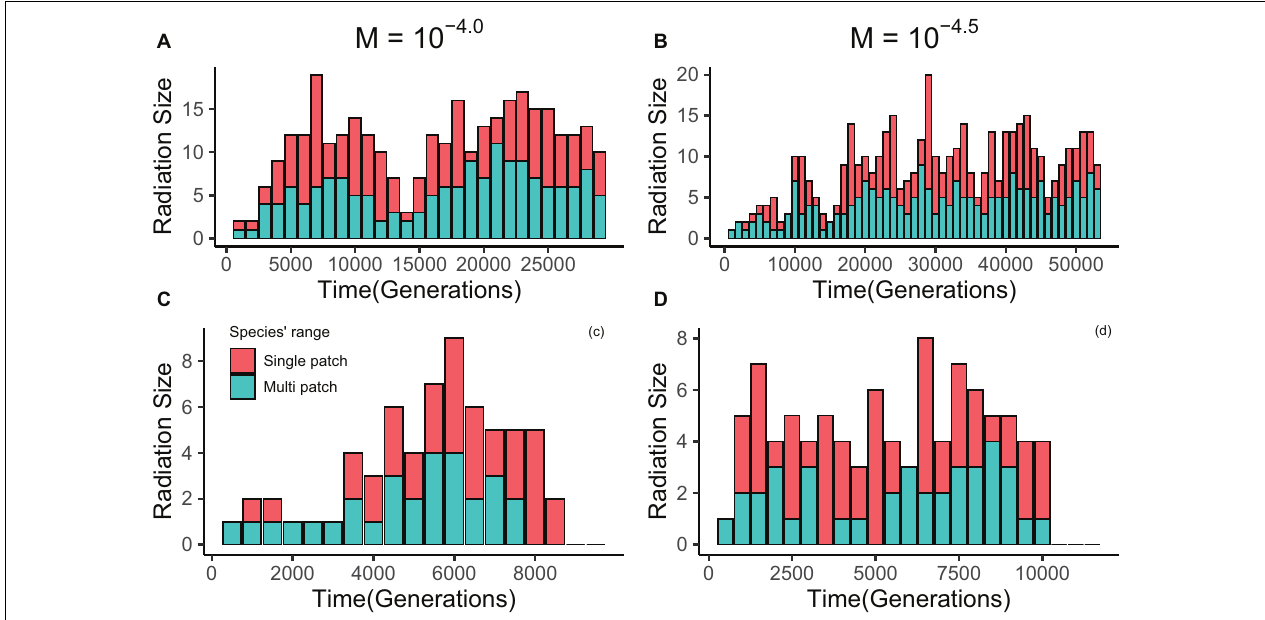
FIGURE 4 | Examples of lineage radiation size through time for 4 well-radiated lineages from two simulations. From each simulation, we chose one lineage that still exists at the end of the simulation and one lineage that has gone extinct. The lineages in panels (A,C) are from one simulation, the lineages in panels (B,D) from another simulation. Data in panels (A,B) were collected every 1000 generations, while the interval in panels (C,D) was 500 generations. The external immigration rate in panels (A,C) is 10 - 4 , and in panels (B,D) is 10 - 4 . 5 . The features of the community simulated were: 4 local patches, each with 1000 individuals; fully-connected spatial structure; internal dispersal rate is 10 - 3 . 5 ; gene flow effect (G) is 0.1. The red portion of the stacked bar represents the species that are only endemic to a single local patch; the portion represents endemic species that have spread onto multiple patches. This figure illustrates that, for our model, fluctuations in radiation size are normal, as is extinction of entire lineages and recovery of nearly extinct lineages to radiate